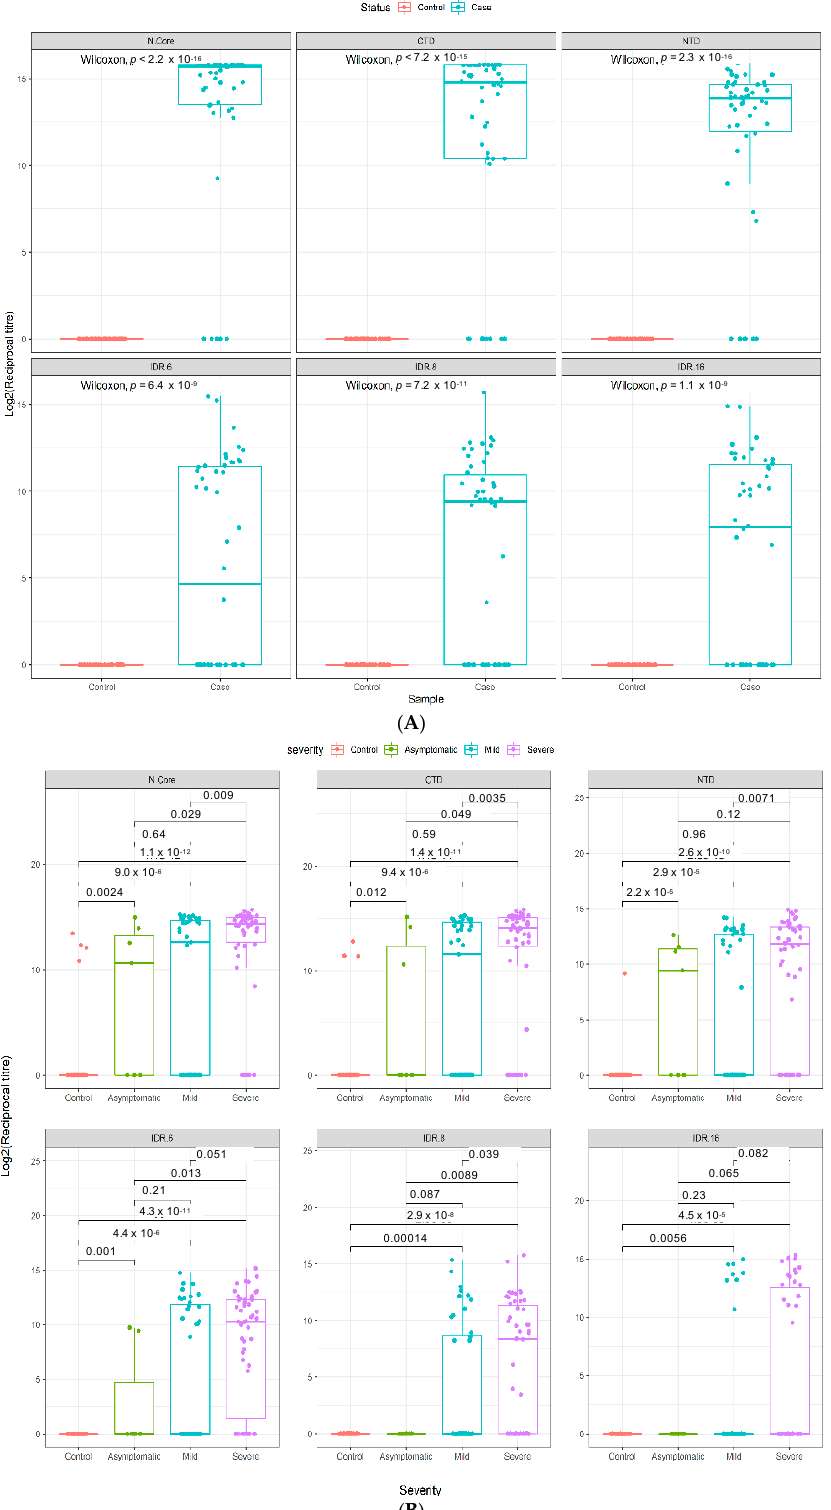
Figure 1. Epitope selectivity of IgG responses in two independent COVID-19 cohorts. Antibody reciprocal titers against different epitopes ( n = 6) of the SARS-CoV-2 N protein in two separate COVID-19 case and control cohorts. ( A ) Validation cohort ( n = 100), consisting of 50 hospitalized COVID-19 patients and 50 pre-pandemic controls (Cohort 2). ( B ) Multi-ethnic cohort ( n = 138), consisting of 50 severe COVID-19 patients, 50 mild COVID-19 patients, and 38 healthy controls (Cohort 3). Boxes represent the 25th and 75th percentiles, and the midline represents the median and whiskers represent the 5th and 95th percentiles. p -values were determined using the Wilcoxon test (unpaired,